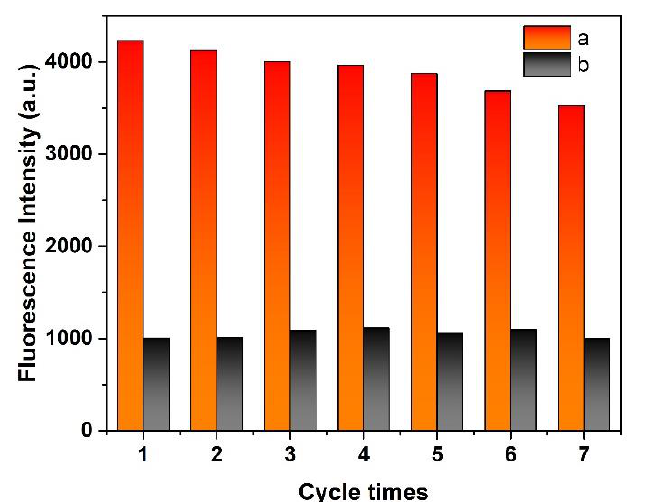
Figure 9. Fluorescence intensity of MIP@QDs; a removal of SAM and b rebinding of SAM.